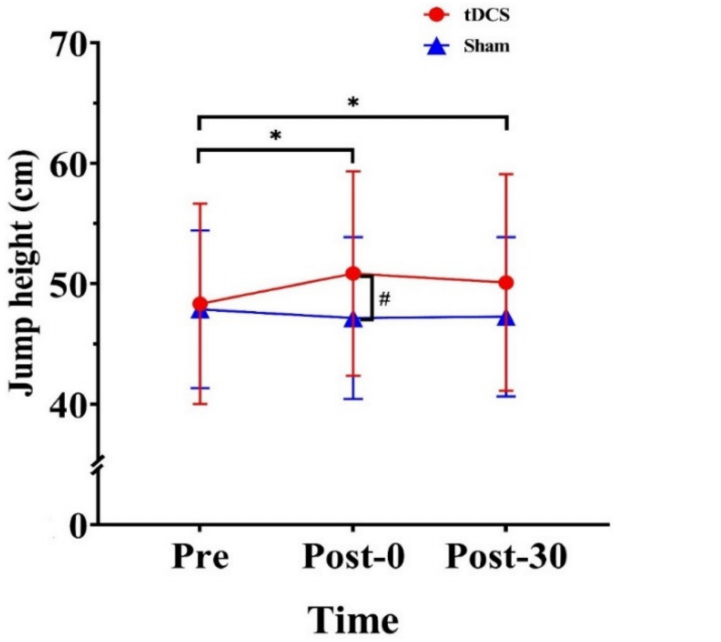
Figure 2. Effects of tDCS on jump height in CMJs. * indicates a significant difference between times. # indicates a significant difference between conditions. Pre: pre-stimulation, Post-0: post-0 min, Post-30: post-30